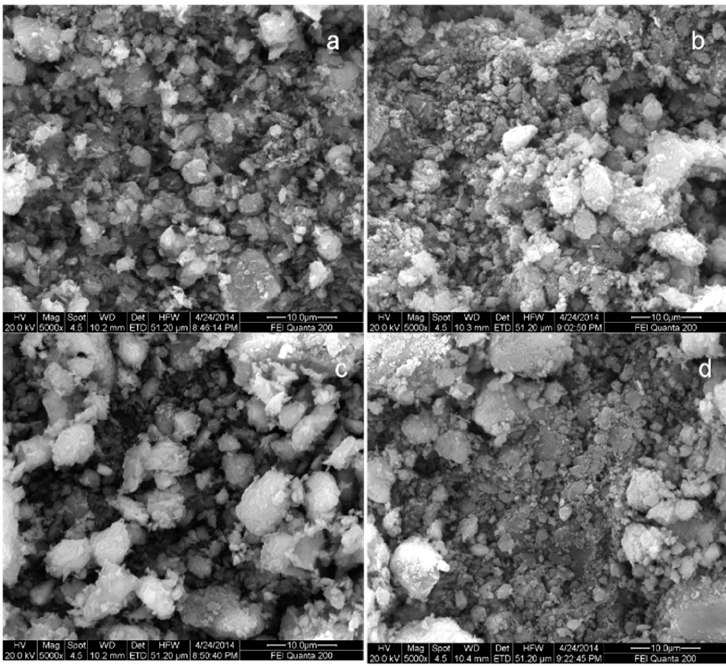
Figure 2. Scanning electron microscopy (SEM) images of the catalysts: ( a ) Au/Na-ABen; ( b ) Au/Ti-Na-ABen; ( c ) Au-Ti/Na-ABen; ( d ) Au-Ti-Ce/Na-ABen.